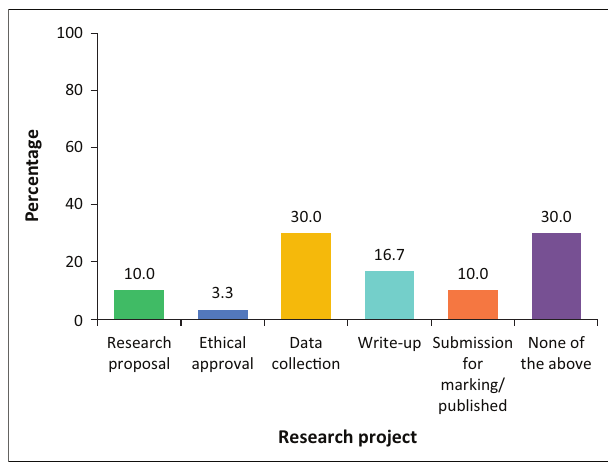
FIGURE 7: Progress with research